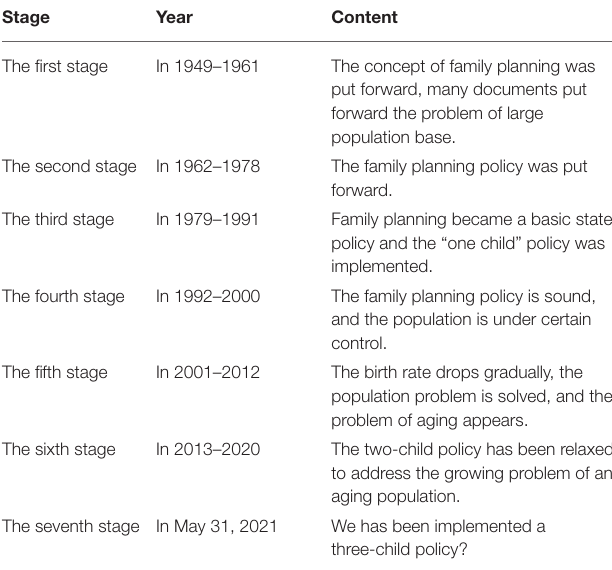
TABLE 1 | The history of China’s reproductive health